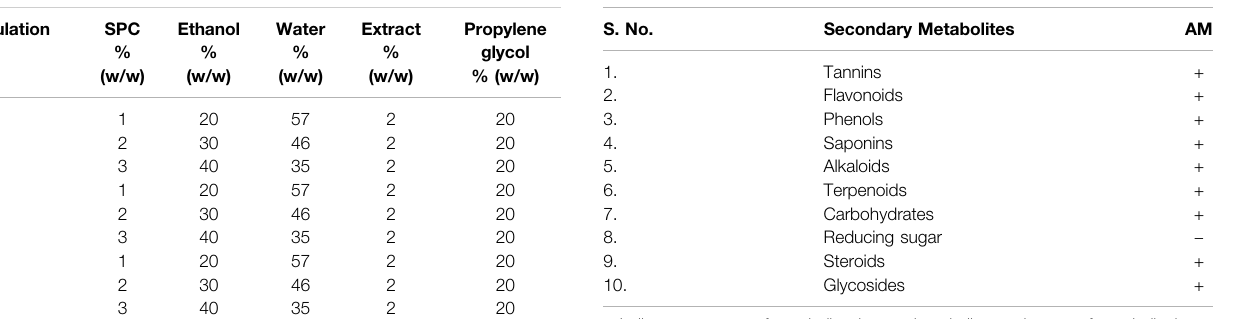
TABLE 2 | Phytochemical analysis of